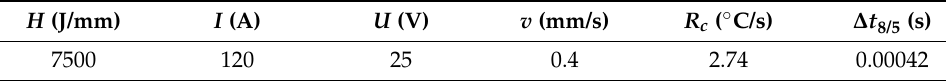
Table 6. Parameter cooling rate of underwater